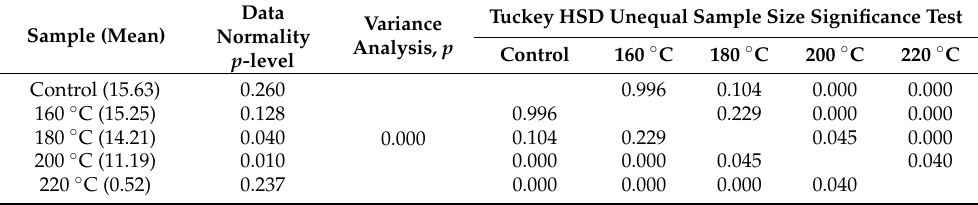
Table 4. Analysis of variance (ANOVA) between heat transfer coefficients of samples with different treatment results.